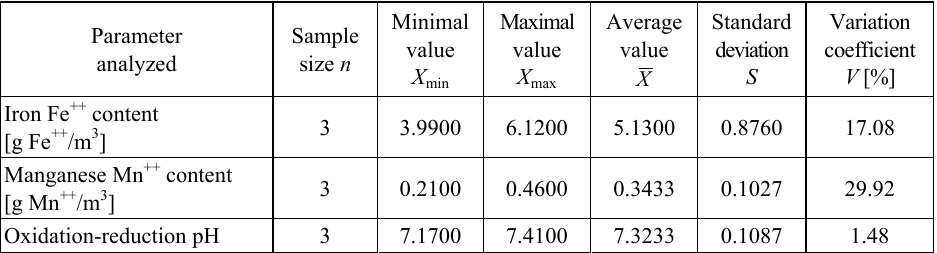
Table 2. Basic statistics of quality parameters of underground water